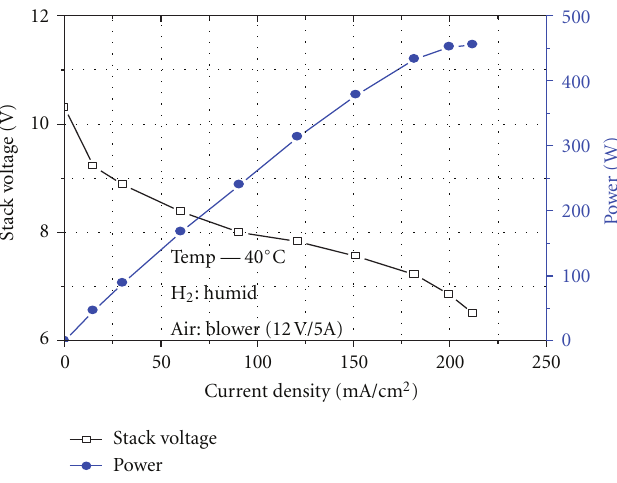
Figure 10: 500 watt fuel cell performance curve.